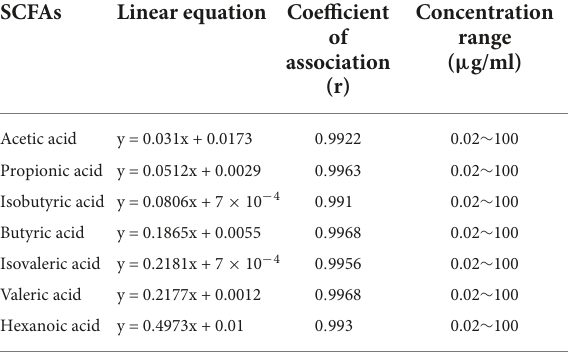
TABLE 1 Short-chain fatty acids (SCFAs) regression linear